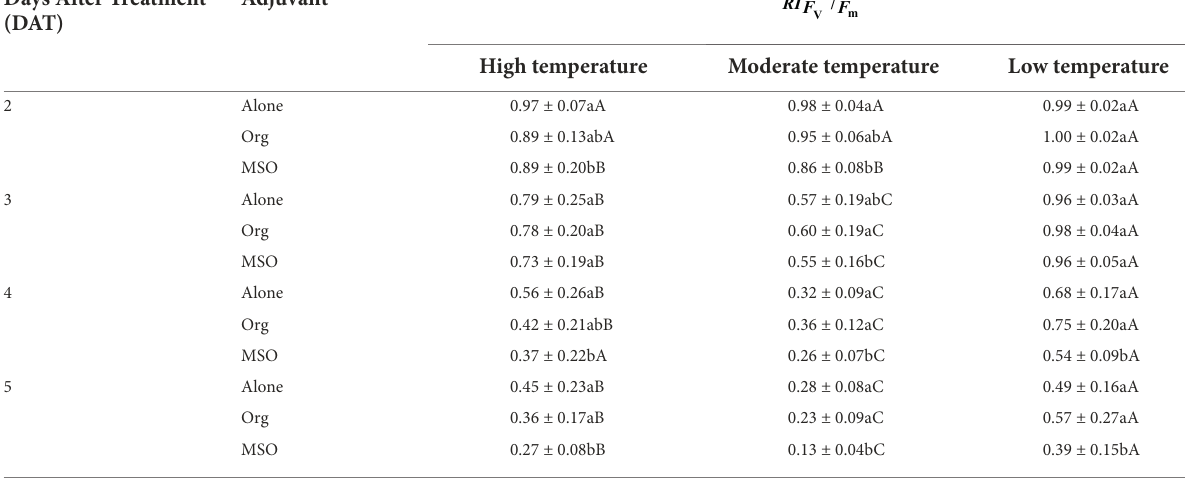
TABLE 2 Effects of two adjuvants on the maximum quantum efficiency (F v /F m ) of giant foxtail (Setaria faberi Herrm.) at 2–5 days after treatment (DAT). Days After Treatment Adjuvant (DAT)